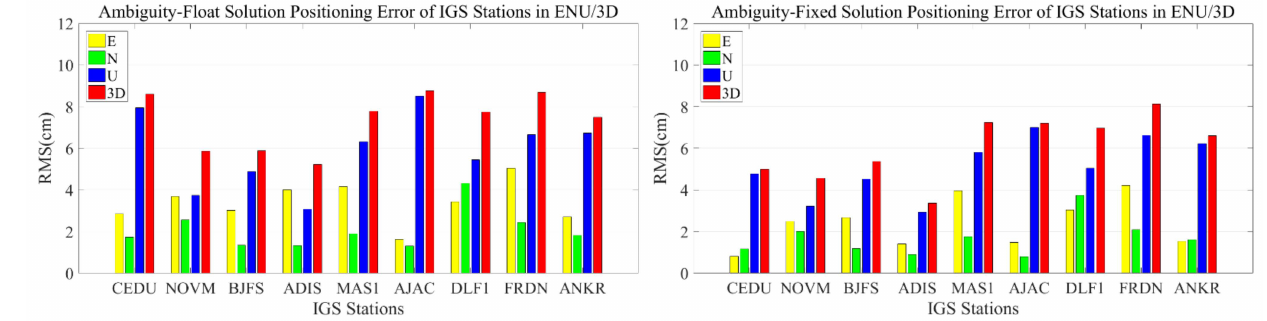
Figure 4. IGS station average positioning error of ambiguity-float ( left ) and ambiguity-fixed ( right ) solutions in E, N, and U directions and